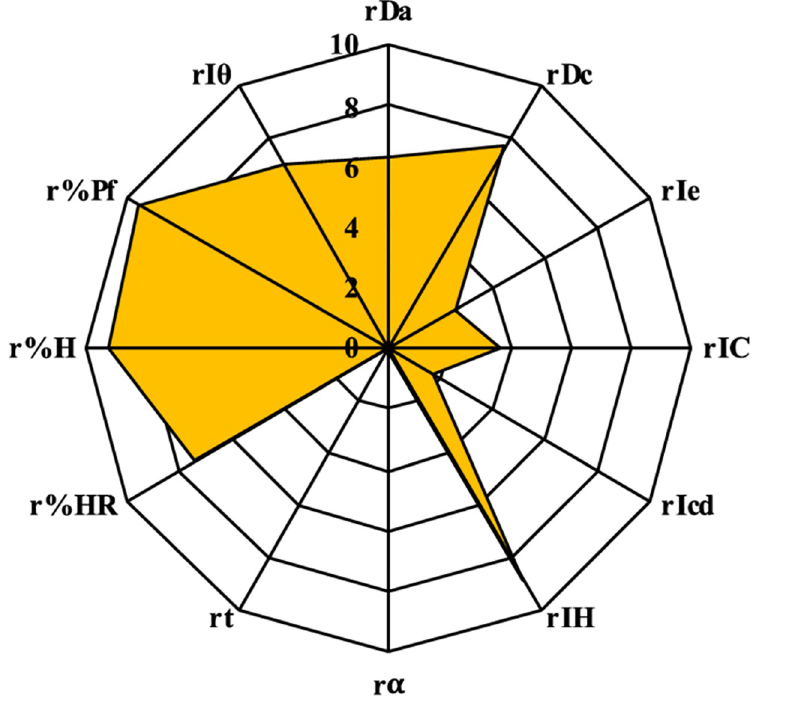
Fig 11. SeDeM rosuvastatin for the calculated parameters (r).